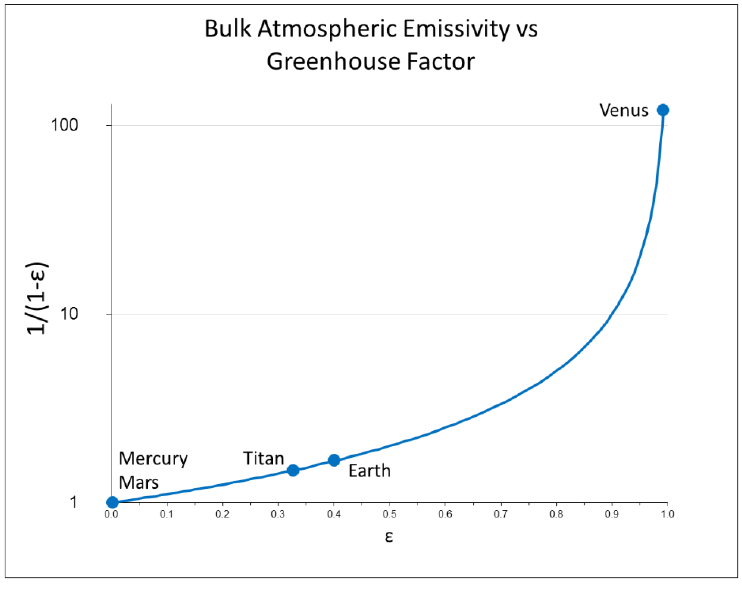
Figure 6. Positions of rocky planets and Titan on the bulk atmospheric emissivity versus greenhouse factor curve. Table 2. Calculated greenhouse factors for rocky planets and Titan.